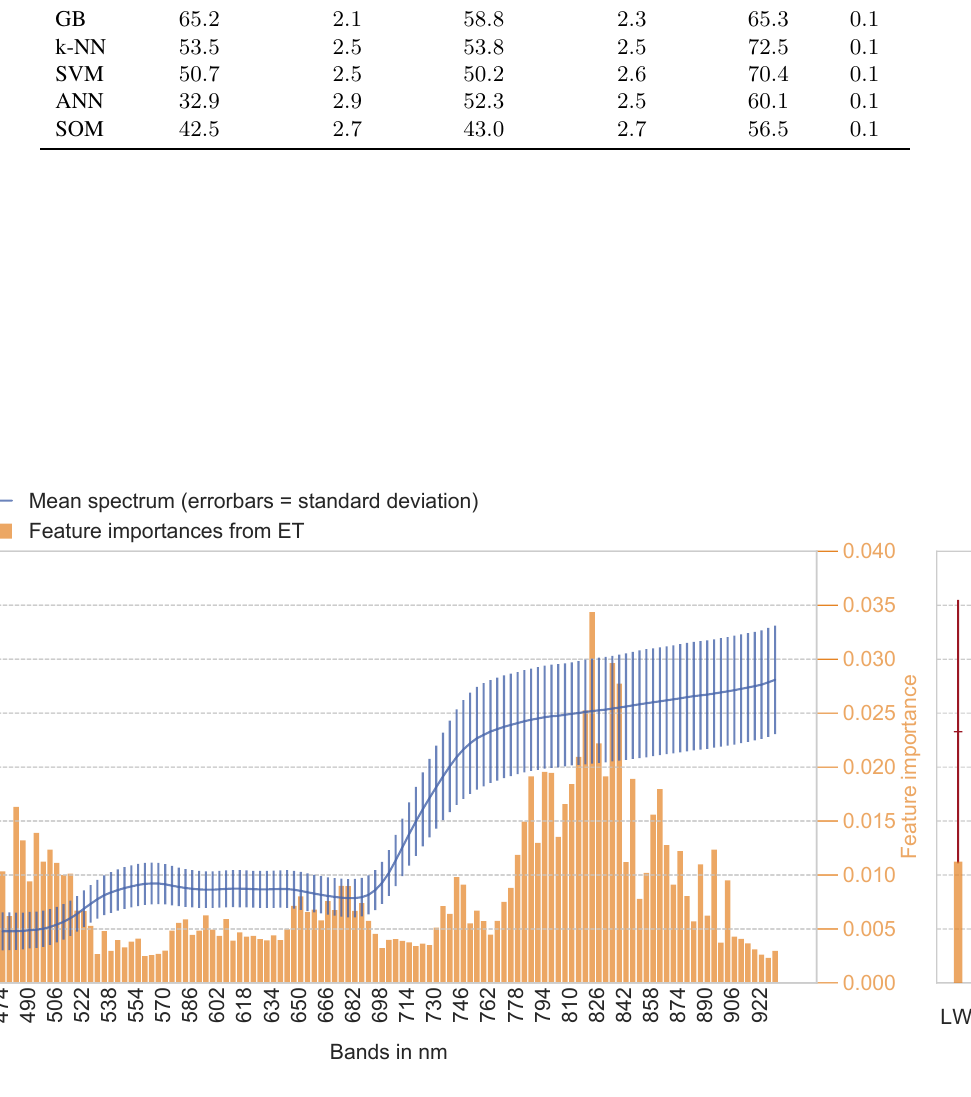
Figure 6. Mean spectrum with the standard deviation as vertical error bars of the hyperspectral data (blue) and the LWIR data (red) of the complete dataset. The feature importance of the ET regressor is shown in